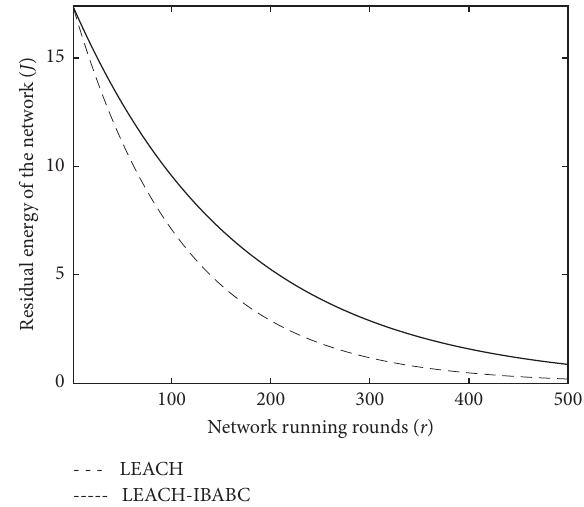
Figure 9: Residual energy comparison of LEACH and LEACH- IBABC vs the number of running